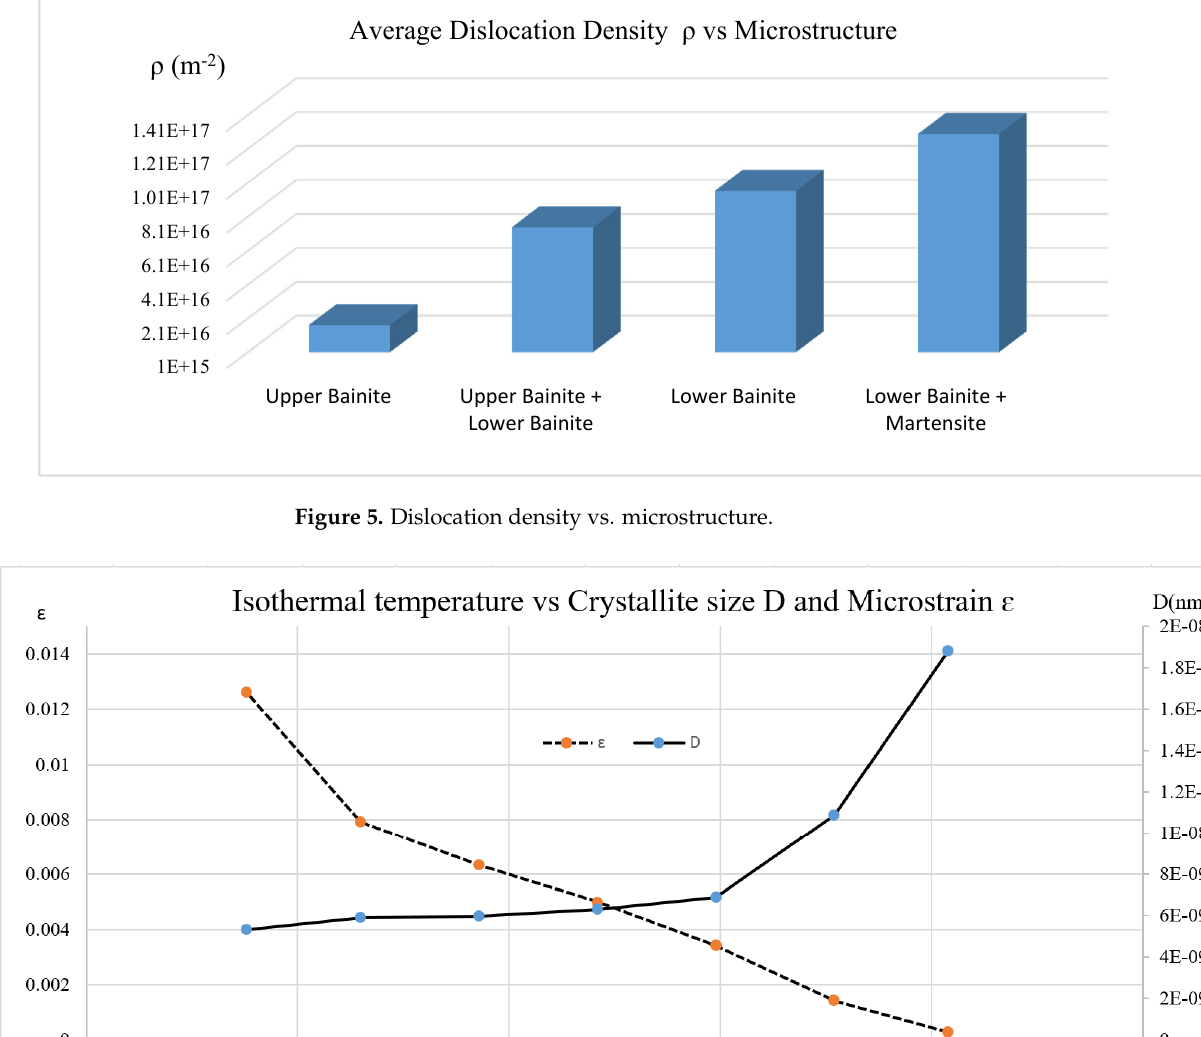
Figure 6. Isothermal temperature effect on crystallite size and microstrain. 3.7. Dislocation Density and Bainite Activation Energy The bainite transformation thermal dynamic driving force is directly proportional to the bainite activation energy, since free energy is needed to initiate the microstructure change in which dislocations will be generated and accumulated. This can be concluded mostly from Figure 7. At higher isothermal temperatures, upper bainite will be trans- formed; the activation energy needed is 167 KJ/mol [39] and the dislocation density aver- age in the upper bainite region is 2.0 × 10 16 (m (cid:2879)(cid:2870) ); see Figure 7. As isothermal temperature is decreased to the lower bainite region, the activation energy needed decreases to 98